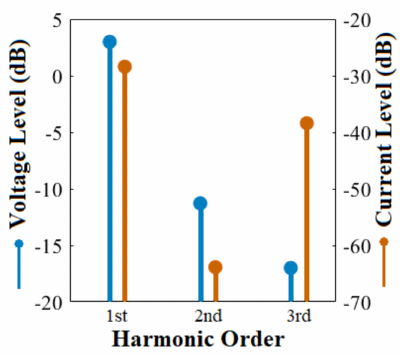
Figure 3. Voltage and current spectrum up to the 3rd harmonic frequency.